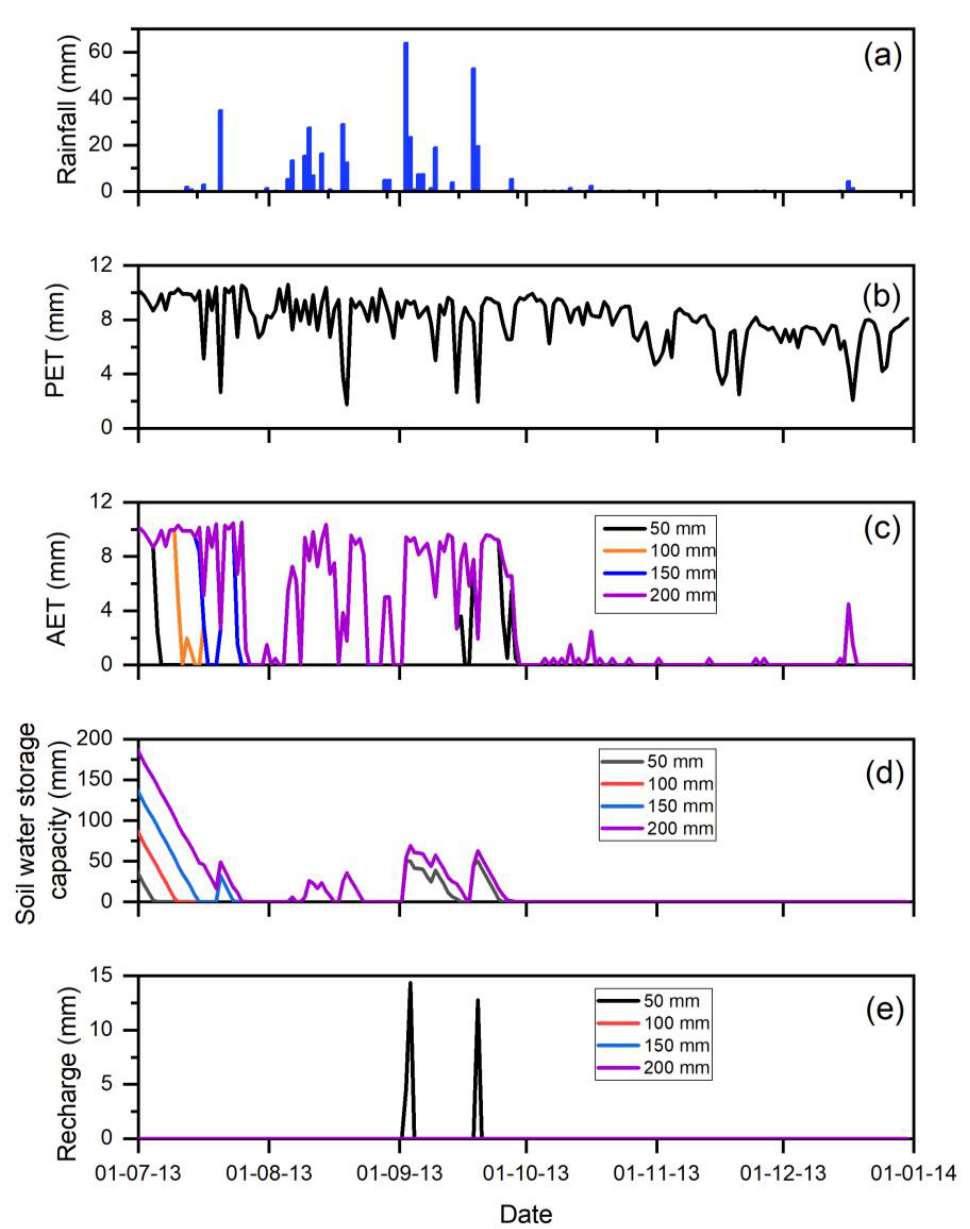
Figure 6. Comparative evolution of recharge as a function of STOMAX values and comparison between the terms of the water balance: rainfall ( a ), potential evapotranspiration ( b ), actual evapo- transpiration ( c ), soil water storage capacity ( d ) and recharge ( e ).